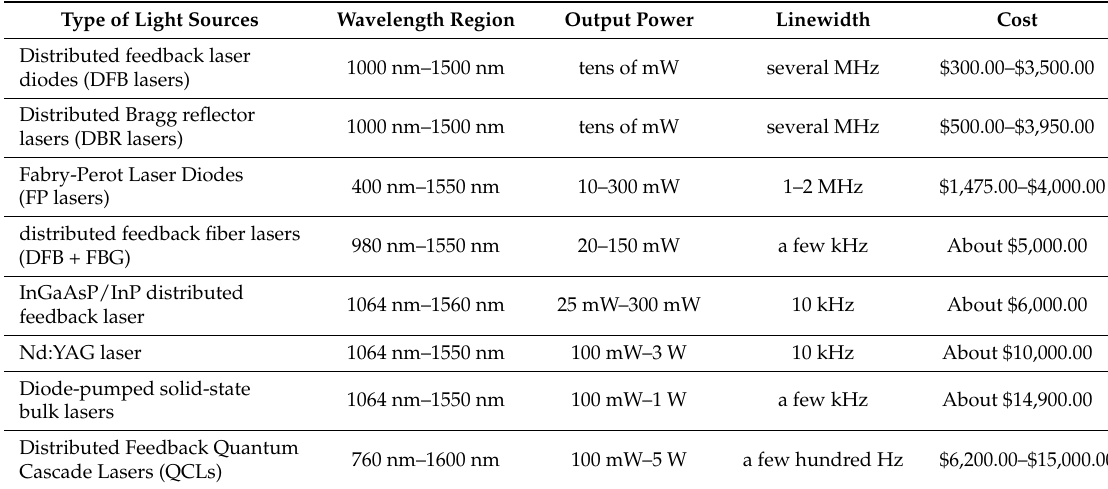
Table 8. Comparison of linewidth and cost for different types of lasers in SDM-based systems.